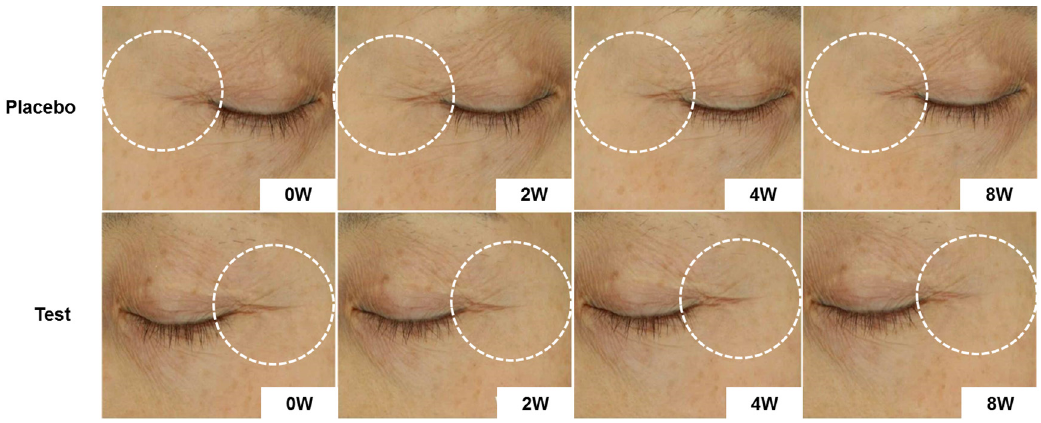
Figure 5. Visual improvement of wrinkles in the crow’s feet area with PGLE application for eight weeks. Skin wrinkle images in crow’s feet following eight consecutive weeks’ application of the test product (Subject No. 15).